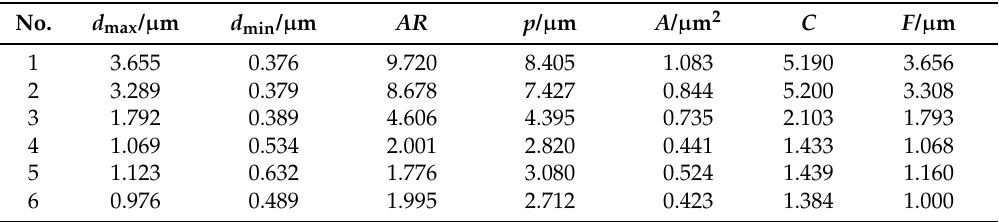
Table 4. Respective measurements for each particle referring to Figure 1c. Indices AR , C , and F correspond to the aspect ratio, circularity, and feret of the measured particles respectively. Accordingly, d max and d min are the major and minor diameters, p is the perimeter and A is the area of particles (refer to Table